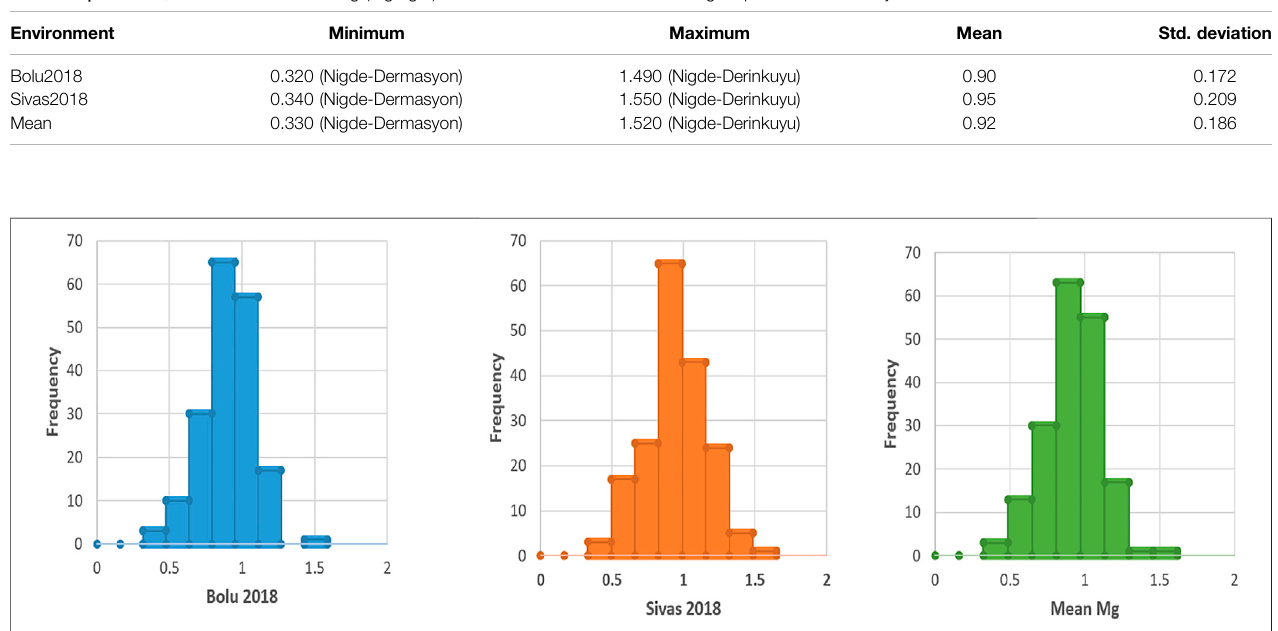
Frontiers in Genetics |